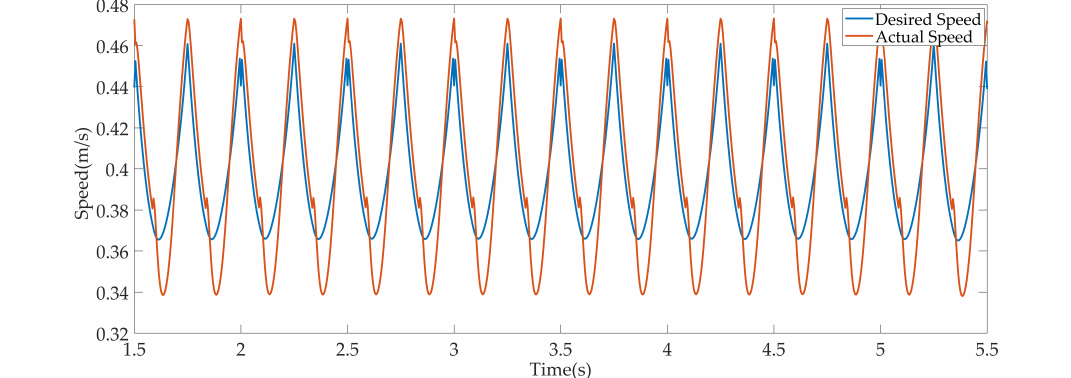
Figure 7. Comparison of the desired and actual CoM horizontal speed trajectories.